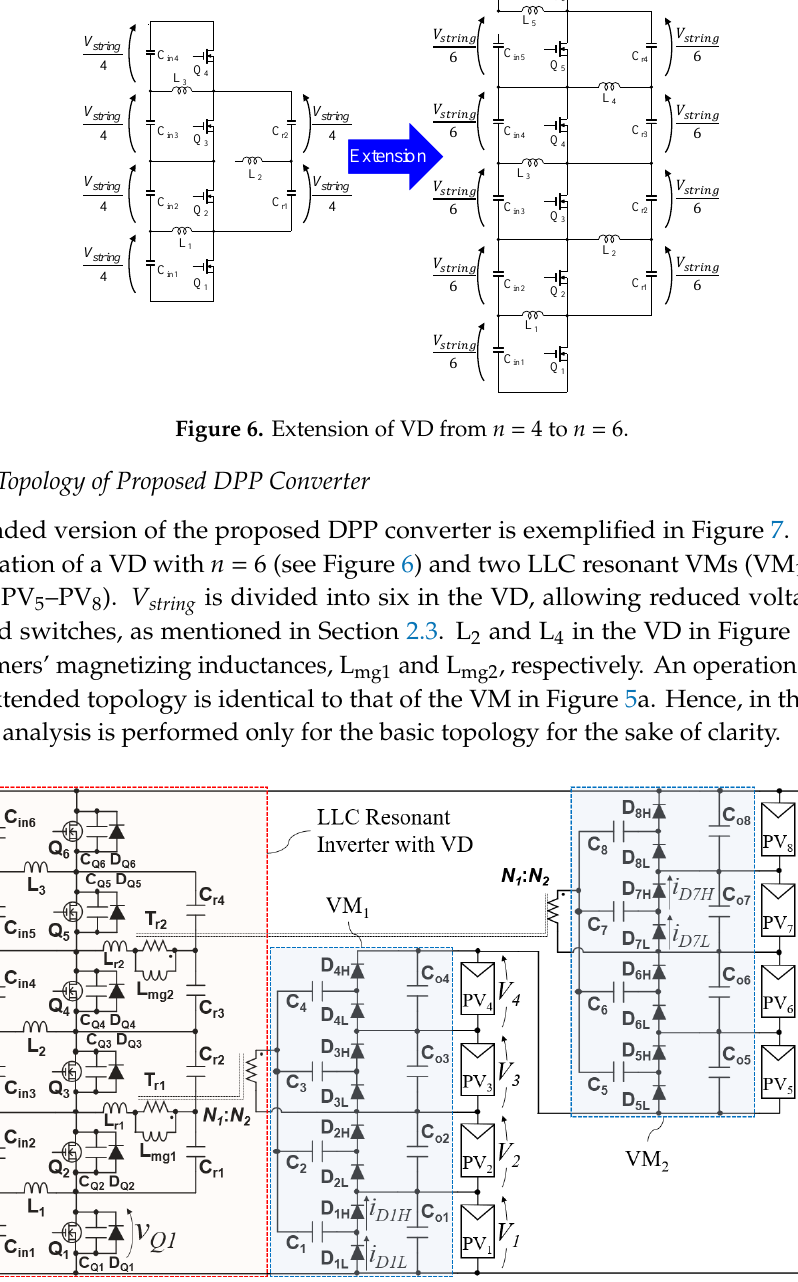
Figure 7. Extended DPP Converter using two VMs and VD with n = 6.